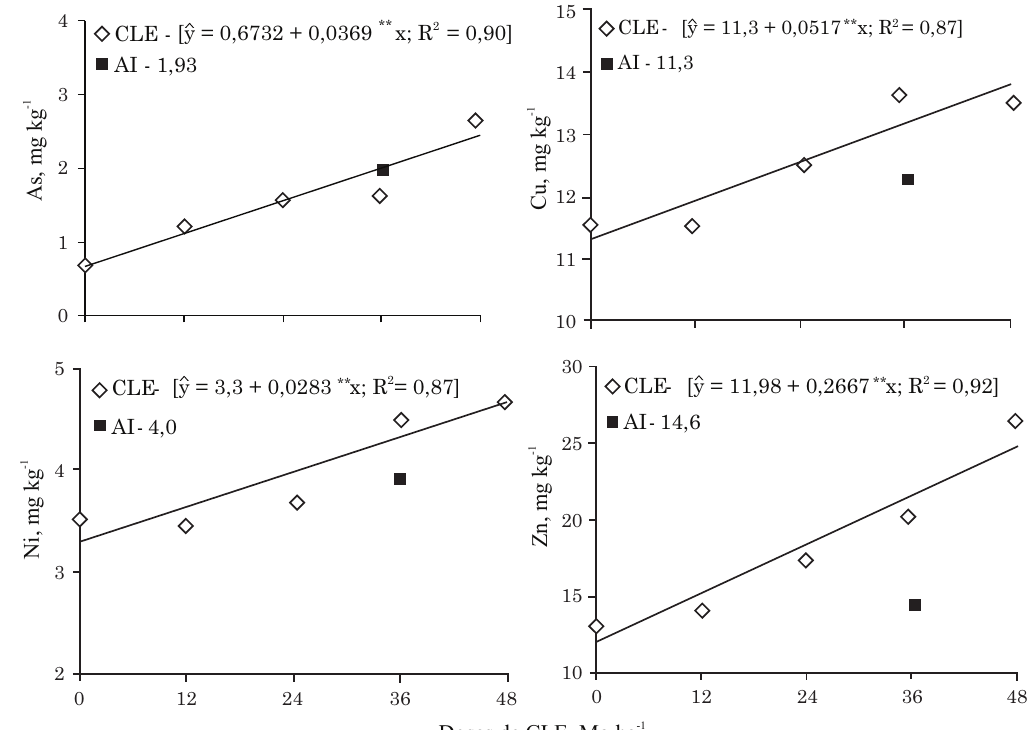
Figura 2. Teores de elementos-traço no solo na camada de 0-0,2m, após o corte de tapetes da grama Imperial, em função de doses de composto de lodo de esgoto (CLE) e adubação inorgânica (AI), aos 13 meses após a aplicação do composto.